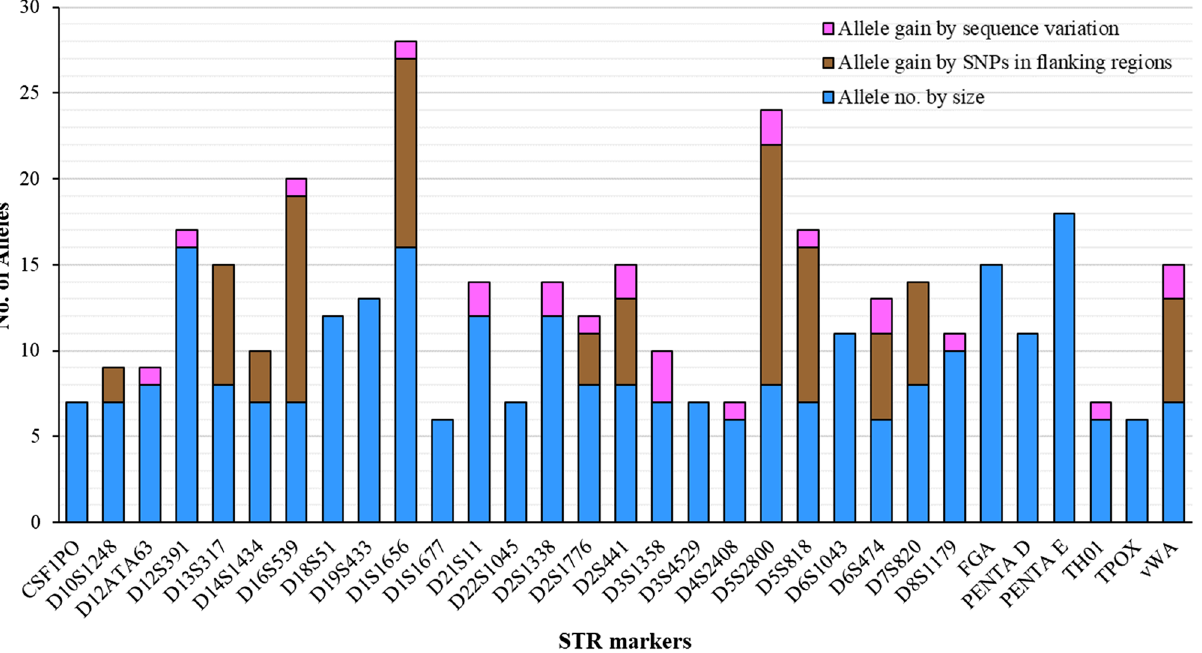
Figure 3. Allele gains by sequences at 31 autosomal STR markers due to SNPs in flanking regions and isometric heterozygous